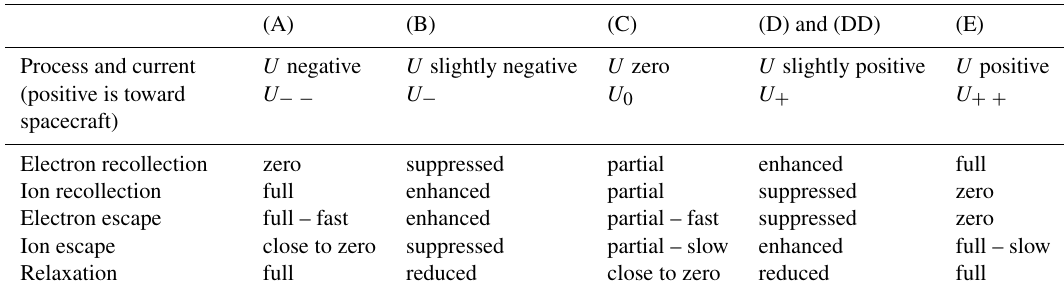
Table 2. Examples of signal development for different biases (spacecraft potential) shown in Fig.